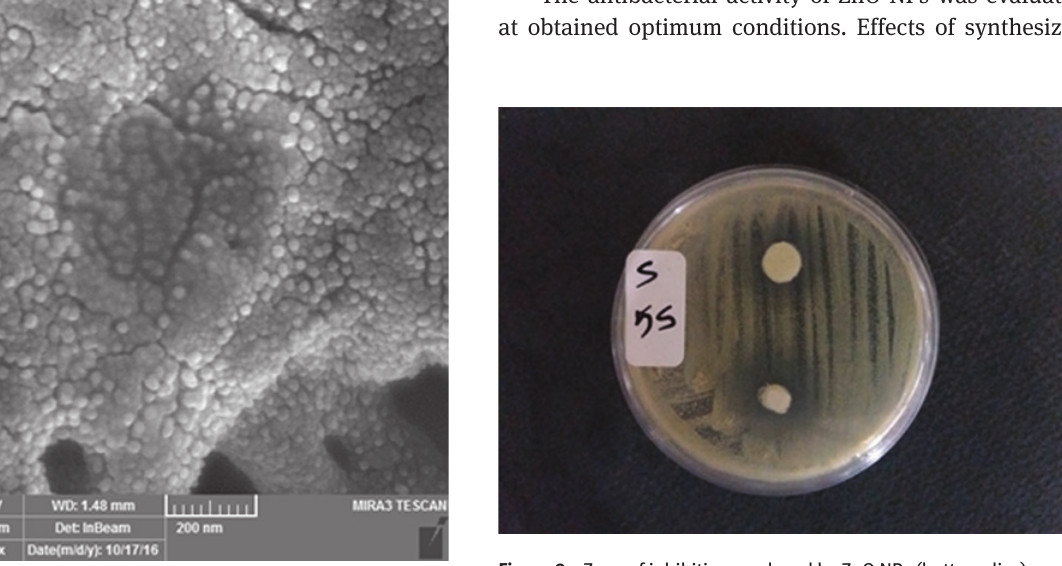
Figure 8: SEM images of ZnO NPs synthesized at optimum conditions.